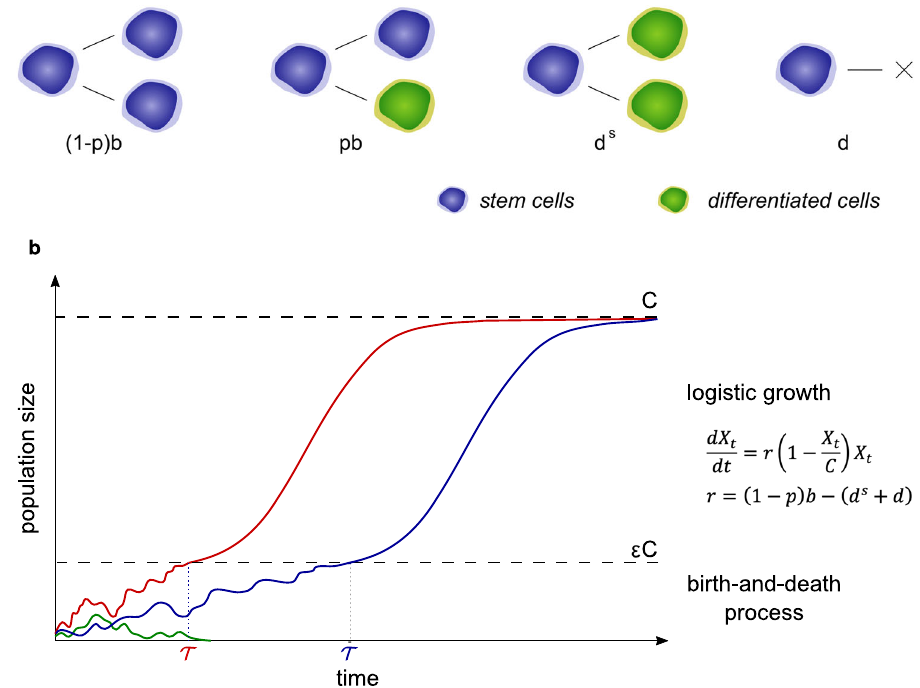
Fig. 5| Growthofa tissuestem cellpopulation. a Rates of self-renewal, asymmetric division,symmetricdifferentiation, anddeathof a stem cell. b Anillustration of the size evolution of three stem cell population trajectories, according to the model described in the Methods